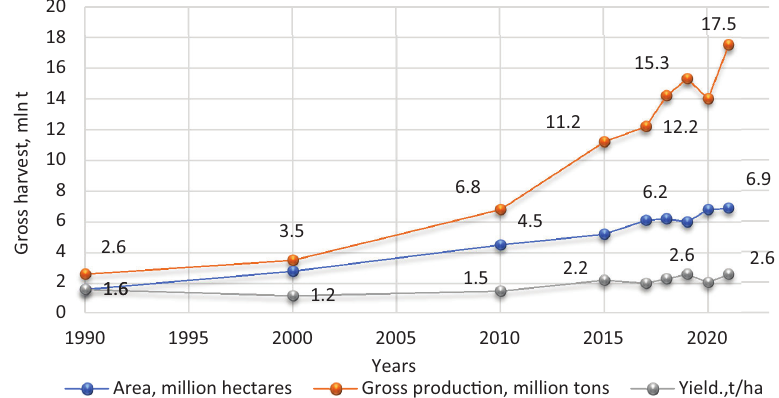
Gross produc(cid:31)on, million tons Yield., t/ha Figure 1. Status and forecast of the balance of sunflower production in Ukraine, 1990–2021 (source: compiled by the authors based on AgroChart, 2021)